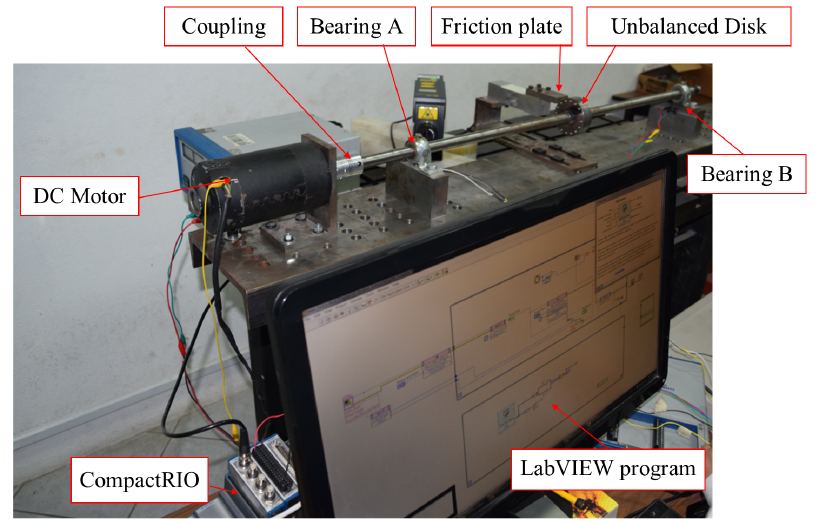
Figure 5. Schematic test bench.